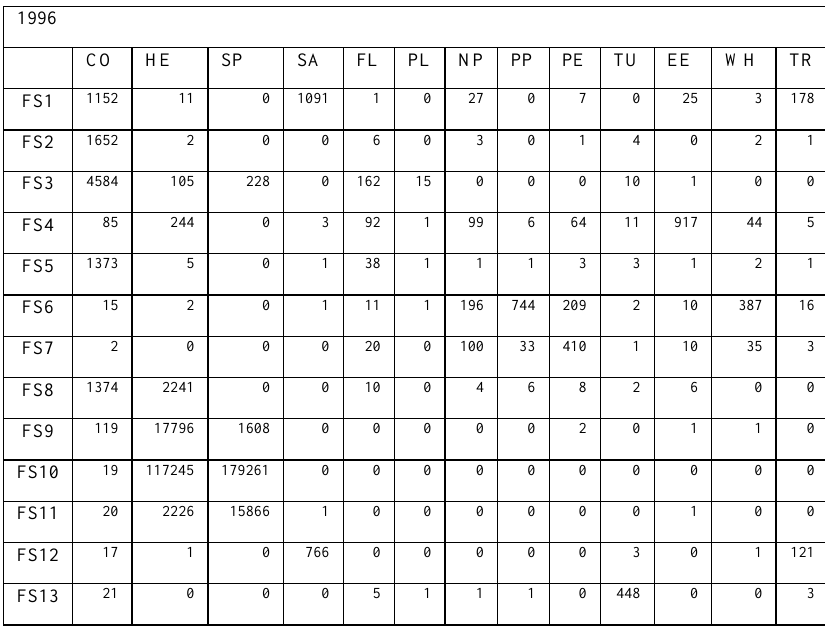
Table A2.1. Data for fishing links as catch (kilograms) per fishing event (trip) per an average fisher in each strategy in 1996. In the social-ecological network construction, a link was added from a fishing strategy to a target fish species if the average catch for a species exceeded 2% of the average total catch for that particular fishing strategy. The following abbreviations are used: FS: fishing